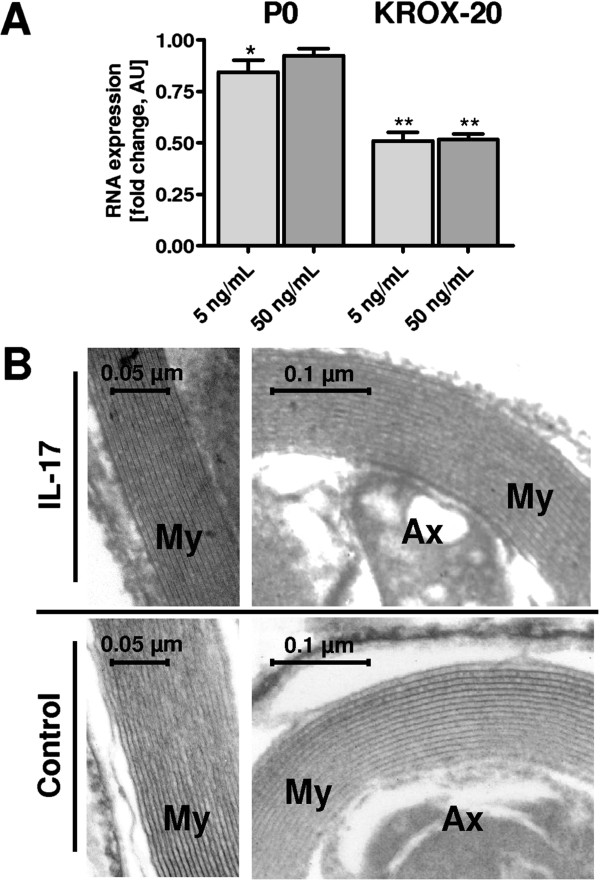
mRNA expression of myelin genes P0, and KROX-20 of rat Schwann cells (rSCs) and myelin morphology after stimulation with interleukin 17 (IL-17). (A) mRNA expression of myelin genes P0 and KROX-20 is normalized to glyceraldehyde 3-phosphate dehydrogenase (GAPDH) and to control cultures. A significant decrease in KROX-20 mRNA expression to 51% (**P ≤0.01) was seen on stimulation with 5 and 50 ng/mL IL-17. P0 mRNA showed a significant down-regulation to 84% expression with 5 ng/mL IL-17 (*P ≤0.05) and a non-significant down-regulation to 92% expression with 50 ng/mL IL-17. For P0 and KROX-20 and both concentrations applied; an analysis of variance between the three independent experiments revealed no significant difference. (B) Ultrastructure of the myelin layer of dorsal root ganglia (DRG) co-cultures after IL-17 stimulation (5 ng/mL IL-17, top row) and control cultures (bottom row). Cultures were stimulated from day 6 after preparation and fixed after 28 days in vitro. The left images depict a longitudinal section and the right images a traverse section referring to the axonal fiber. Myelin showed no morphological alterations after IL-17 stimulation. AU, arbitrary unit; Ax, axon; My, myelin layer.